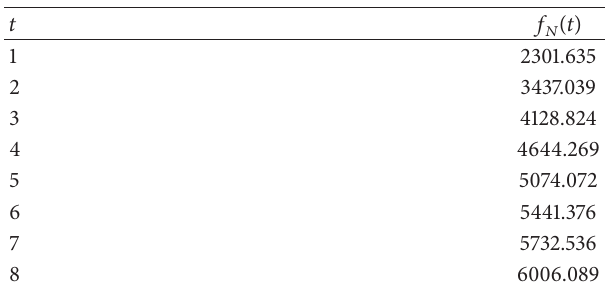
Table 6: The discrete function 𝑓 𝑁 (𝑡) in (26).